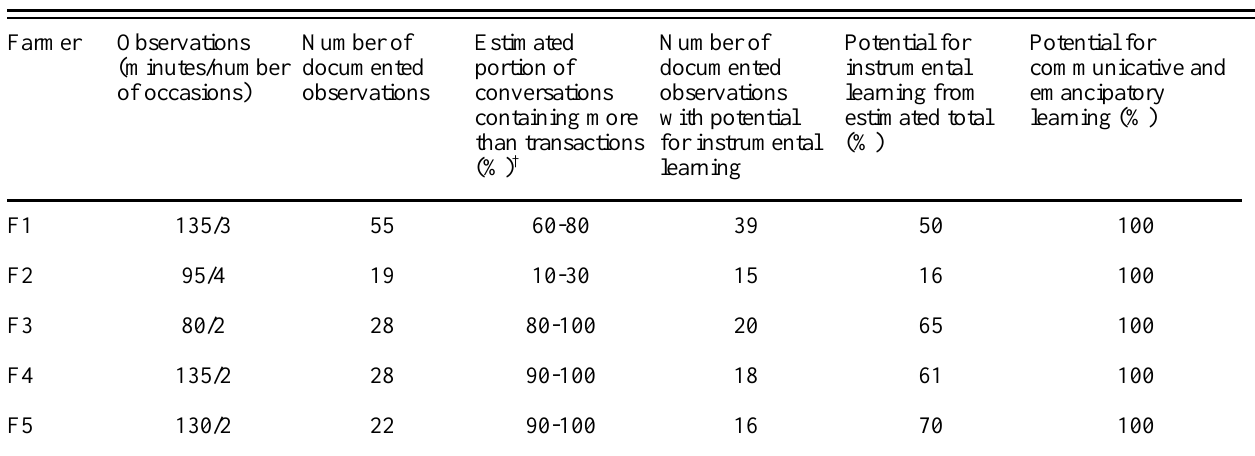
Table 6 . Observed learning potential at the farmers' market.